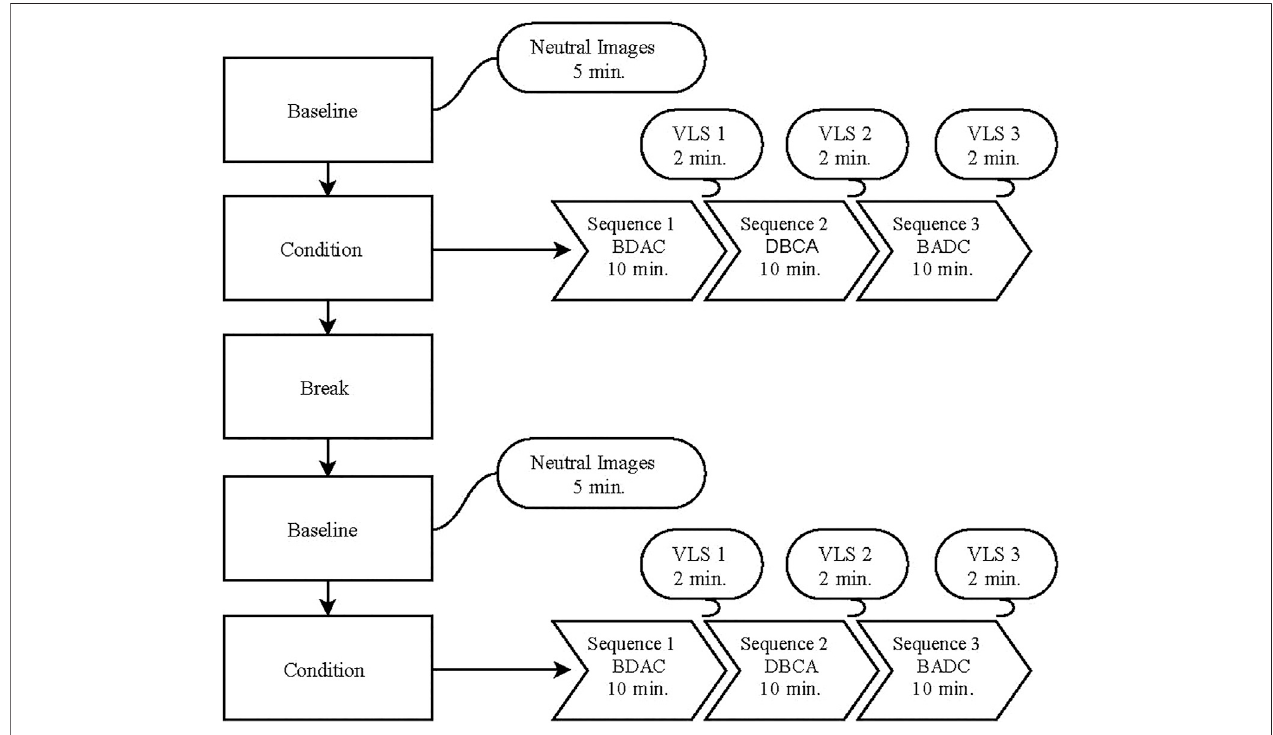
FIGURE 2 | A complete overview of the experimental